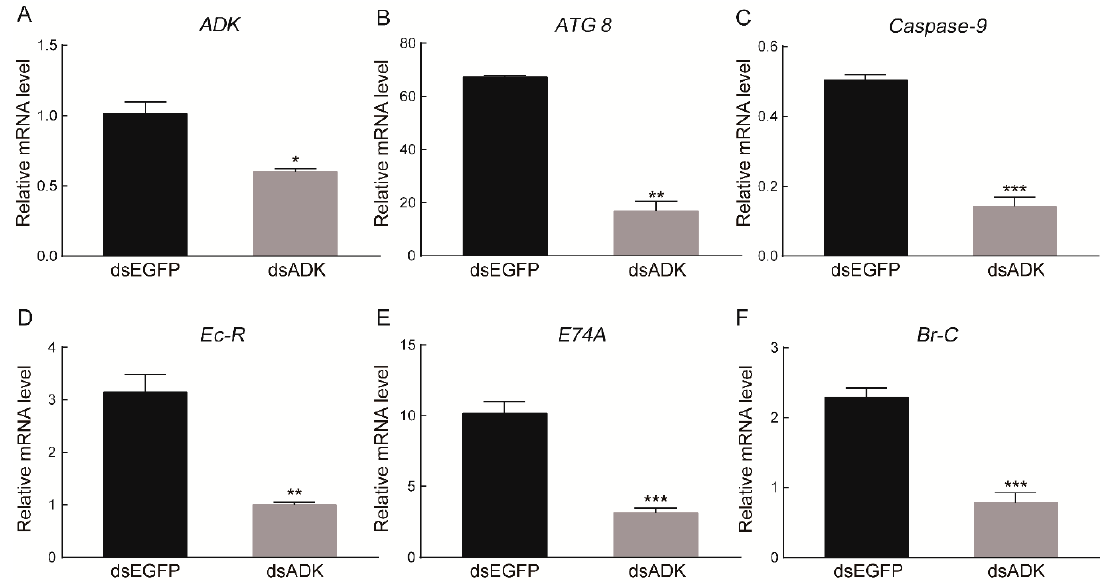
Figure 5. Effects of BmADK RNAi on cell apoptosis, autophagy, and 20E signaling. ( A ) BmADK expression at 36 h after RNAi with ds-BmADK. The expression of ( B ) ATG 8 , ( C ) Caspase-9 , ( D ) Ec-R , ( E ) E74A , and ( F ) Br-C at 36 h after RNAi with ds-BmADK. EGFP was used as the control. All experiments were performed in triplicate. Data are represented as mean ± SD. *, p < 0.05; **, p < 0.01; ***, p < 0.001, compared to the control.